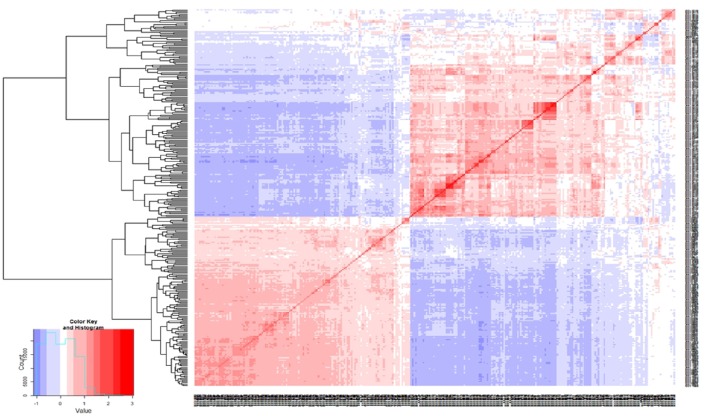
Genetic relatedness among the 315 elite lines. Distance matrix was calculated using average linkage clustering. Heat map of the kinship matrix and dendrogram analysis using genotyping data clearly depicts the existence of two different group among the elite lines.